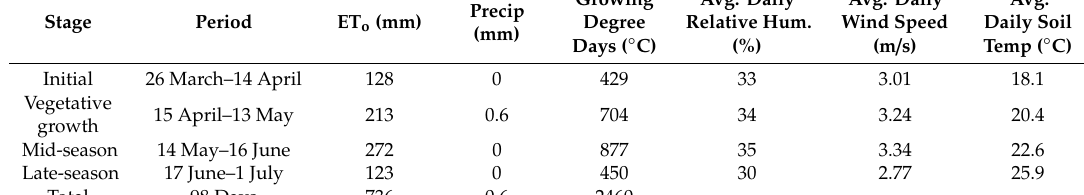
Table 1. Evapotranspiration data through the growing stages [26].